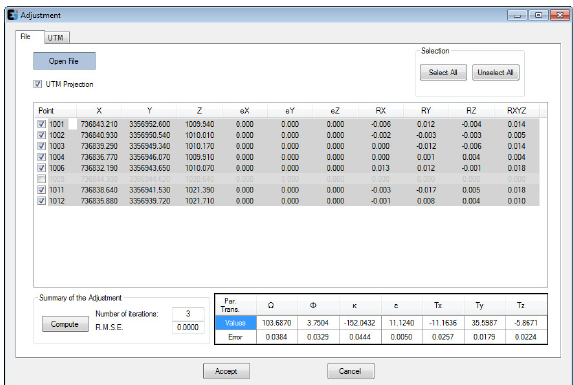
Figure 8. Results of the 3D transformation adjustment in 3DVEM – GEO in the UTM coordinate system